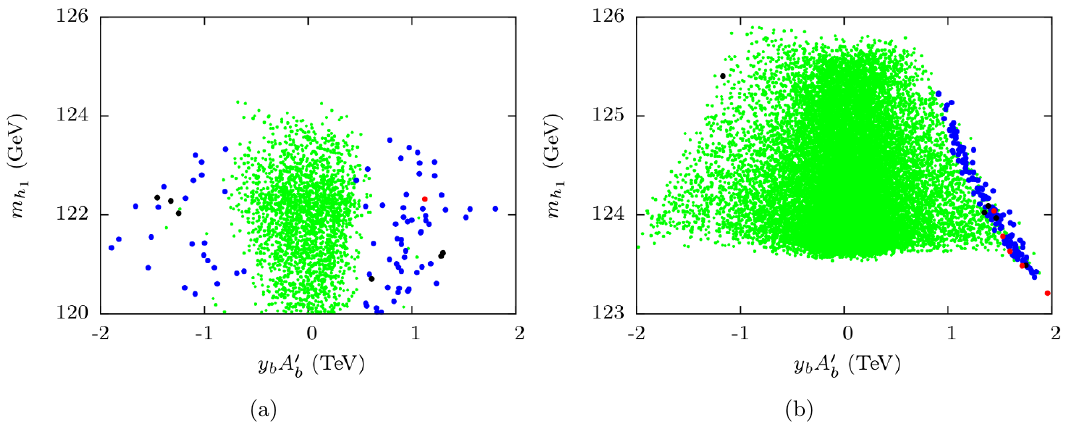
Figure 7 . Figure 7(a) shows the stability pro(cid:12)le in y b A 0 sponding to scan of eq. (3.4). Figure 7(b) is a similar plot for 40 < tan (cid:12) < 50. The color codes for stability pro(cid:12)le is same as that for (cid:12)gure